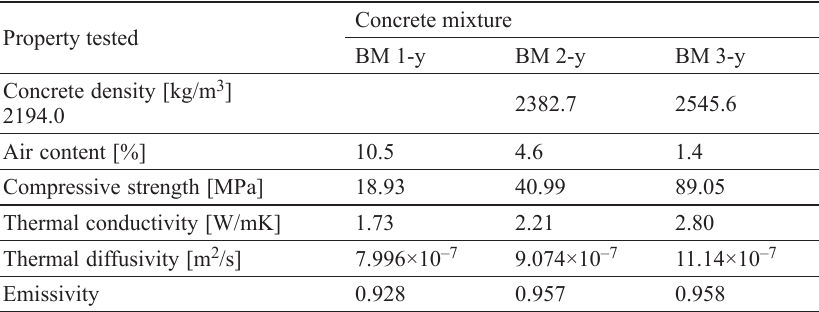
Table 1. Properties of concrete used for creating test specimens Property